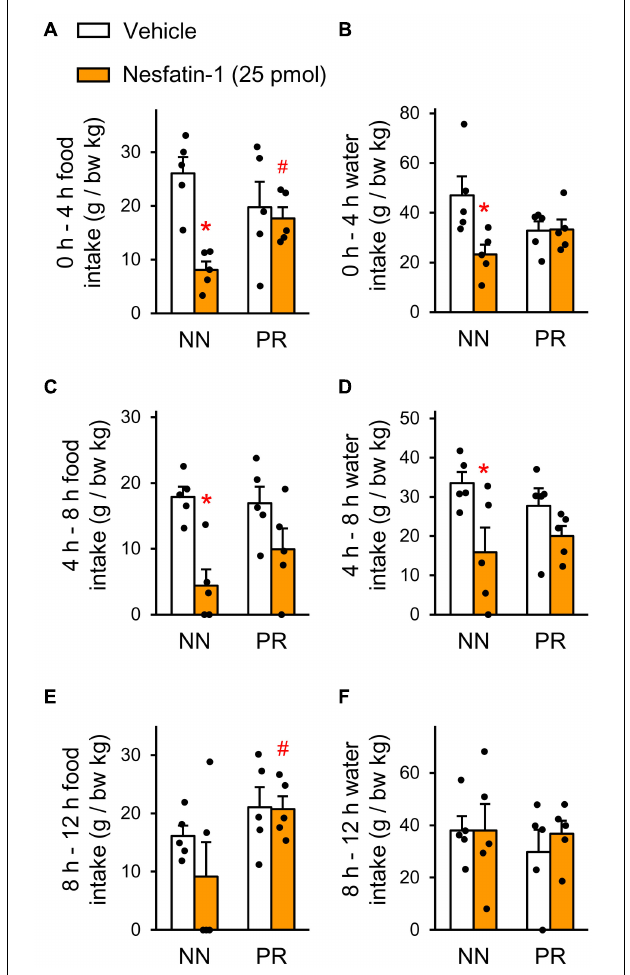
FIGURE 4 | Effect of acute intracerebroventricular (icv) injection of nesfatin-1 (25 pmol), or vehicle on nocturnal food and water intakes of NN and PR rats. Food (A,C,E) and water (B,D,F) intakes of 12 week-old NN and PR rats were measured at 4 h intervals. Zero is the timepoint of treatments. (A,B) 0–4 h. Two-way ANOVA, food intake, effect of treatment F ( 1 , 16 ) = 10.43, p = 0.005 treatment × phenotype: F ( 1 , 16 ) = 6.530, p = 0.021, water intake, treatment × phenotype: F ( 1 , 16 ) = 5.66, p = 0.030. (C,D) 4–8 h. Two-way ANOVA food intake, effect of treatment: F ( 1 , 16 ) = 16.85, p < 0.001, water intake, effect of treatment: F ( 1 , 16 ) = 8.51, p < 0.010. (E,F) 8–12 h. Two-way ANOVA, effect of phenotype: F ( 1 , 16 ) = 5.04, p = 0.039; NN vs. PR within nesfatin-1, p = 0.041. Effects of nesfatin-1 are impaired in PR rats. Tukey multiple comparison tests, * p < 0.05 vs. NN-vehicle, # p < 0.05 vs. NN-nesfatin-1. Means ± SEM, n = 5 for all